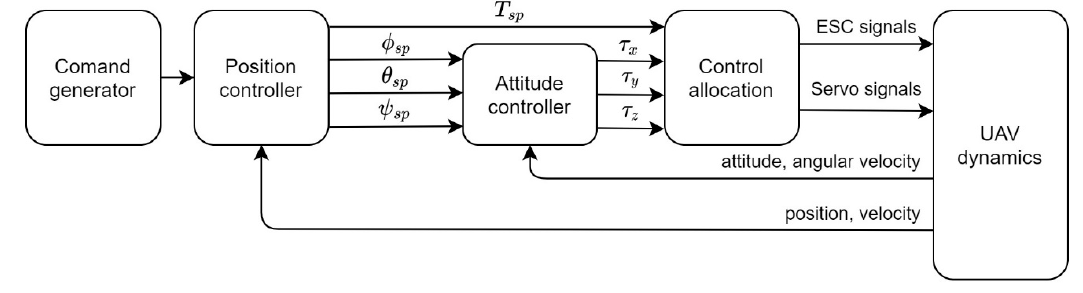
Figure 5. Flow chart of the simulation environment.